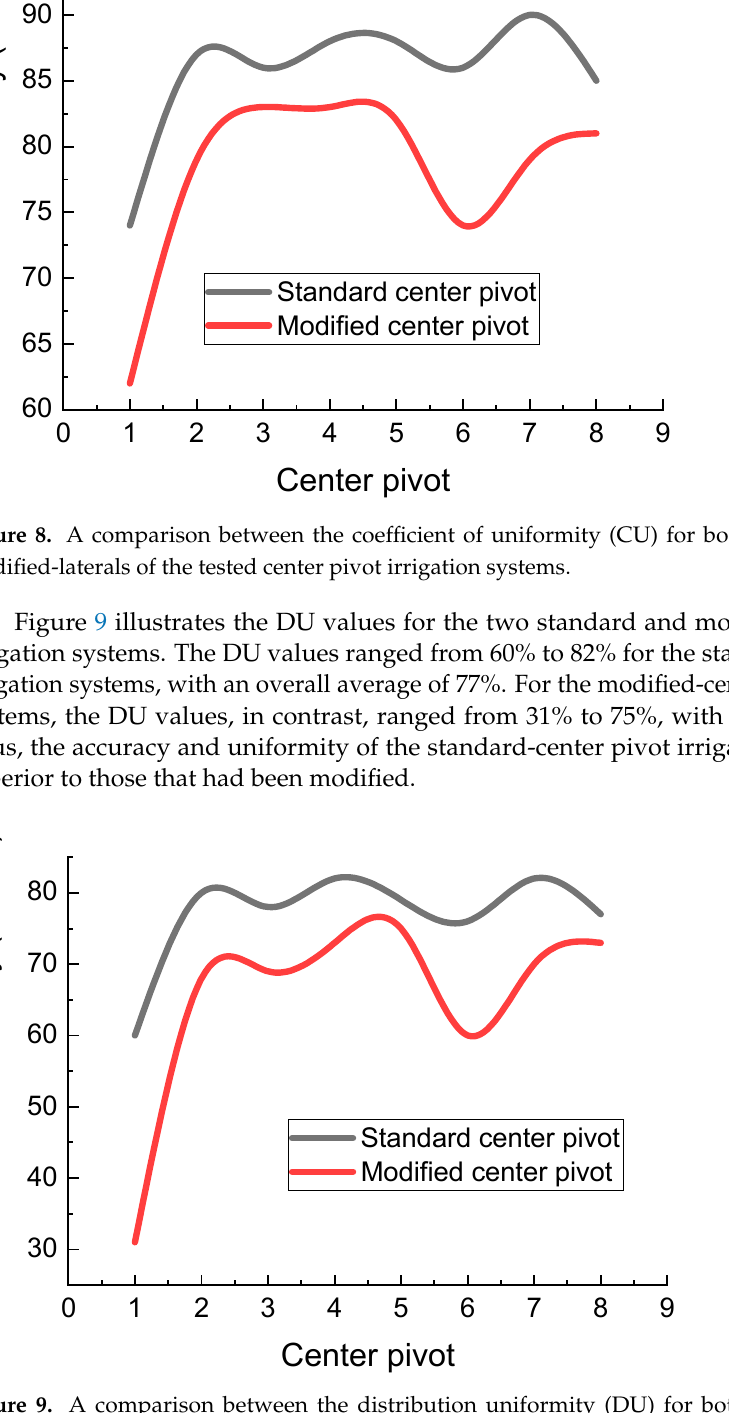
Figure 9. A comparison between the distribution uniformity (DU) for both the standard- and modified-laterals of the tested center pivot irrigation systems.